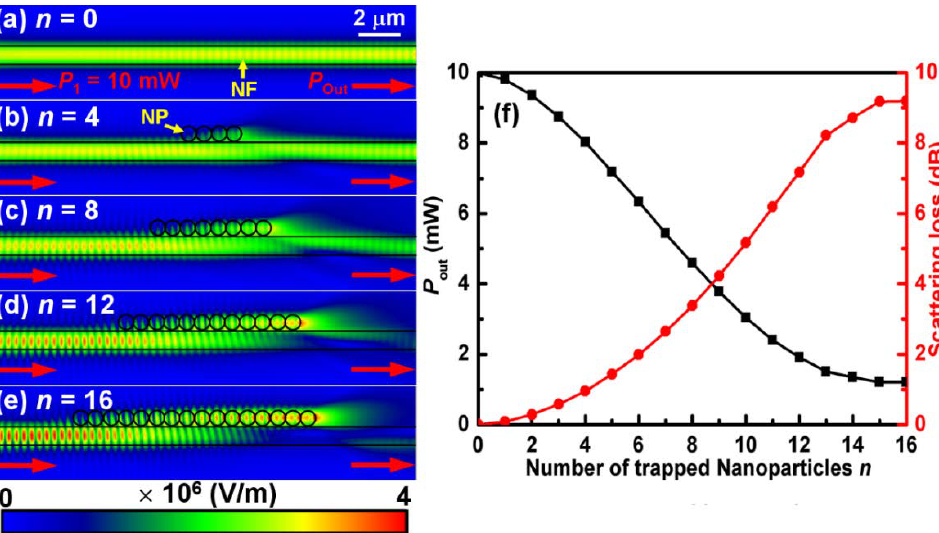
Figure 4. Simulation and calculation results for the scattering characteristics of the NPs chain on the NF. ( a − e ) S imulated optical field distributions with the different number ( n ) of the trapped NPs in the formed chain and the same incident optical power ( P 1 = 10 mW). ( f ) The output optical power P out and the calculated scattering losses l with different n